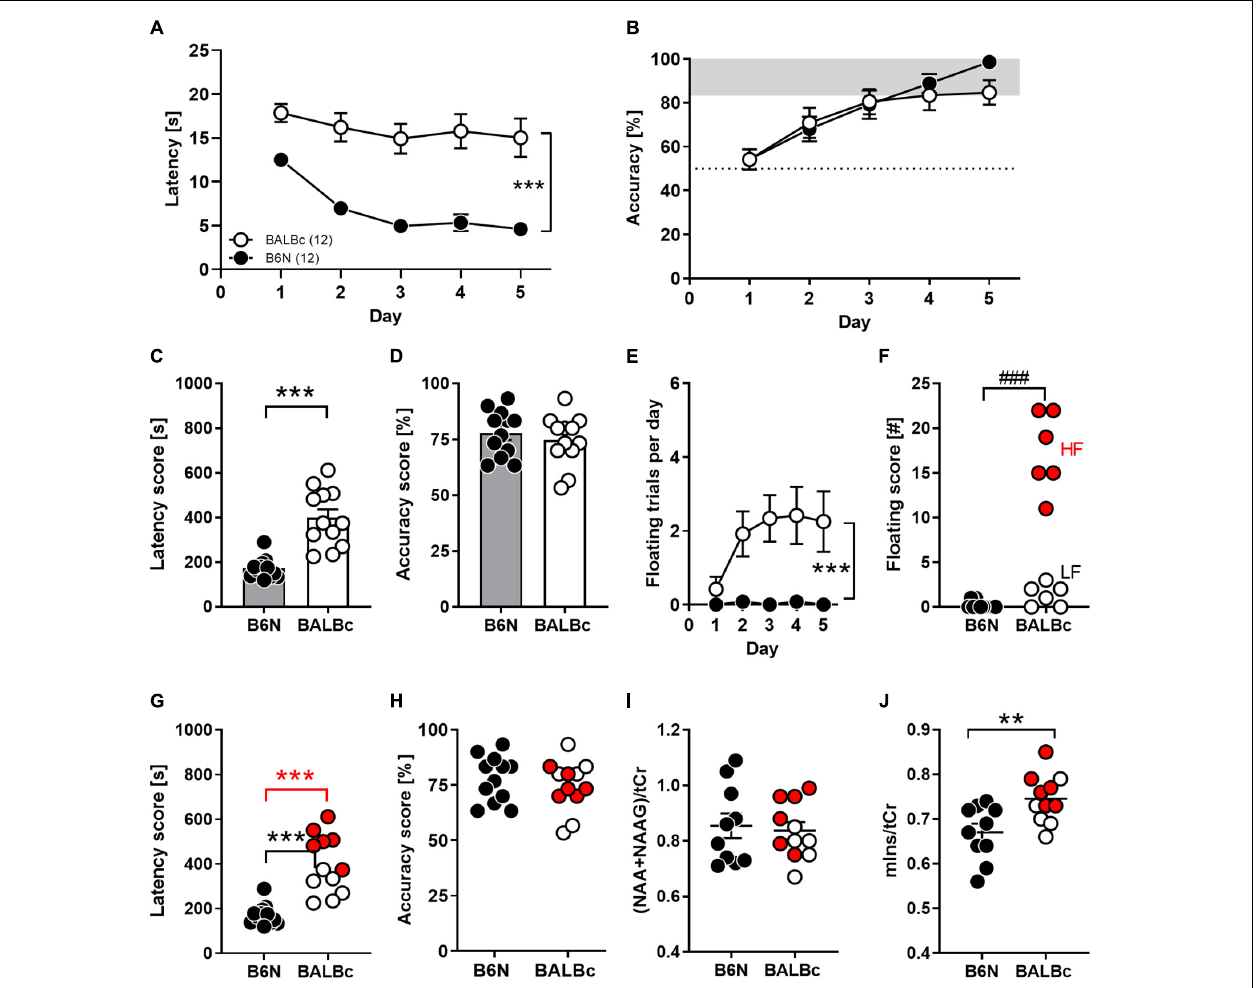
FIGURE 1 | Performance deficits in spatial learning in the Water Cross Maze (WCM) coincided with increased mIns levels in the dorsal hippocampus of BALBc mice. Eight weeks old B6N ( n = 12) and BALBc ( n = 12) mice were trained in the WCM to locate a hidden platform which was kept at a fixed position. Thereafter, metabolite levels were measured with In vivo 1 H-MRS in the dorsal hippocampus. (A,C) BALBc mice showed significantly greater escape latencies, but (B,D) no differences in accuracy throughout training. (E,F) BALBc showed a higher incidence of floating behavior, regardless if high levels of floating (HF) or low levels of floating (LF). (G) HF and LF BALBc mice showed higher escape latencies compared to B6N, (H) without affecting accuracy. (I,J) In vivo 1 H-MRS measurements in the dorsal hippocampus after training revealed significantly higher levels of myo-inositol (mIns), but not NAA + NAAG compared to B6N. Interestingly, this effect